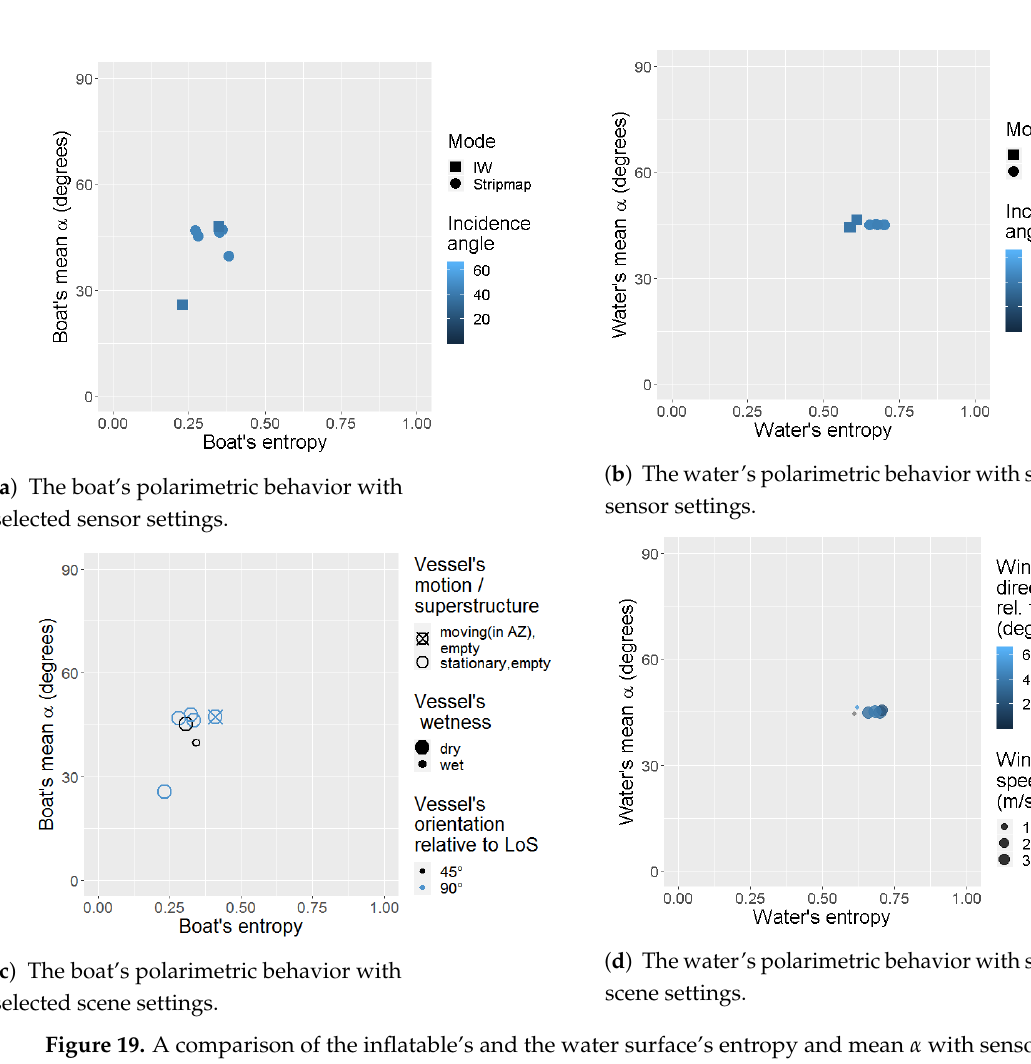
Figure 19. A comparison of the inflatable’s and the water surface’s entropy and mean α with sensor settings and scene settings for cross-polarization